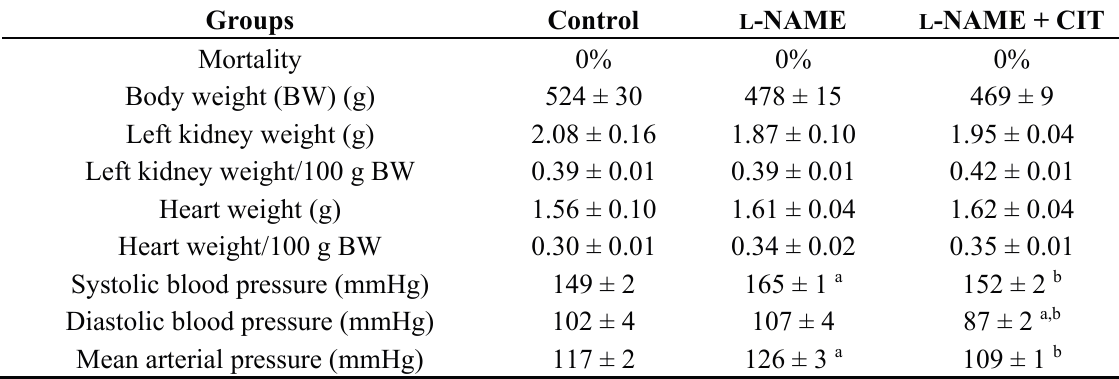
Table 1. Weights and functional parameters in rats at three months of